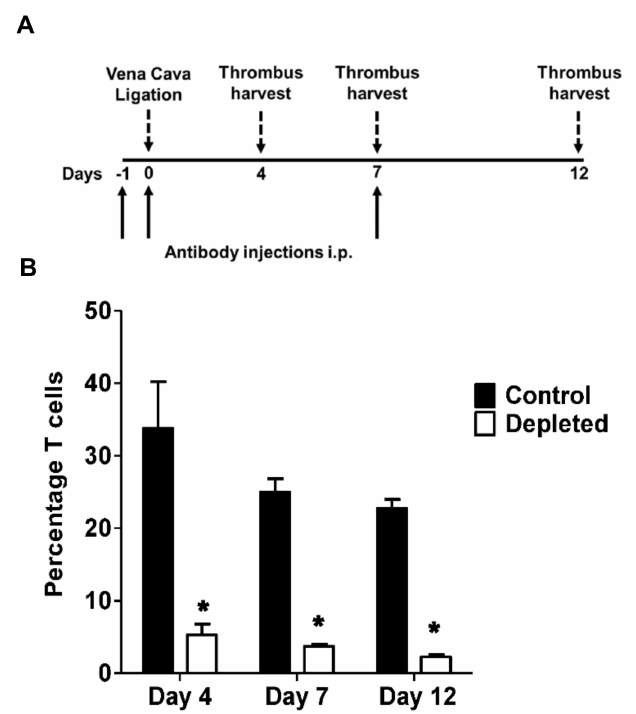
Figure 2. Depletion of T cells in animals impairs venous thrombus resolution. ( A ) Schematic representation of the experimental plan. Solid arrows indicate time-points (days) at which intraperitoneal injection of the antibodies were performed. ( B ) Quantitative analysis of CD3 positive T cells by flow cytometry of spleen lysates from control and T cell depleted animals at various post-surgery days. All values represent the mean ± SEM. ( n = 3–4 per time point). * p < 0.05, control versus T-cell